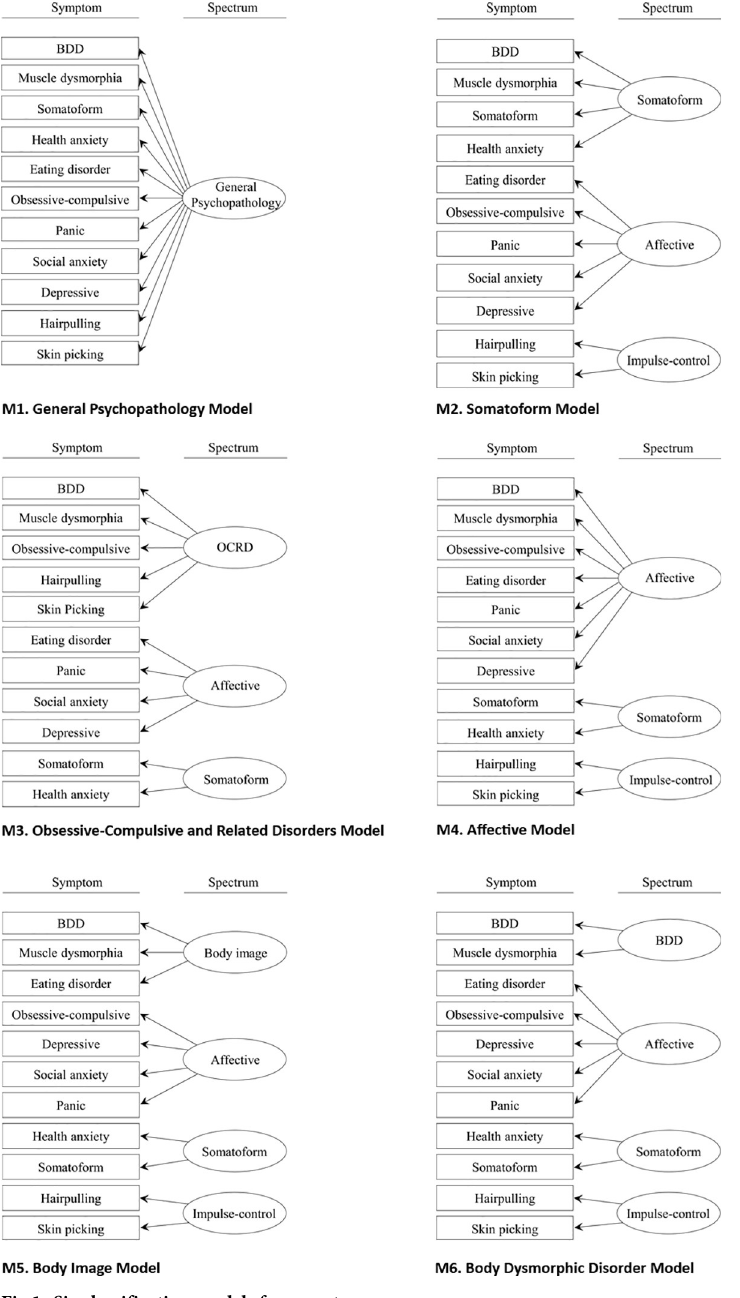
Fig 1. Six classification models for